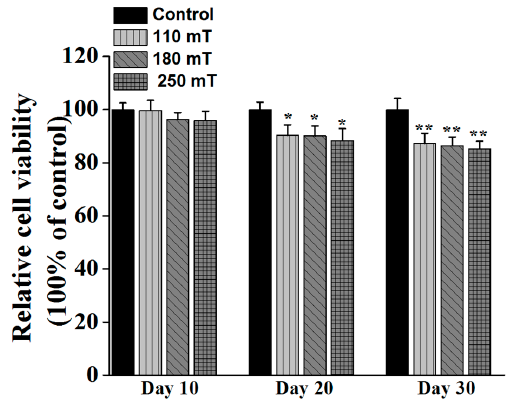
Figure 7. MTS viability of MG-63 osteoblast-like cells growing on ellipsoidal multilayered 3D structures having the layers spatially separated by cylindrical pillars, as a function of the applied static magnetic fields. Results for unstimulated samples (controls) are shown for comparison. Each bar represents the mean ± STD. Statistical significance was determined by Student’s t -test (* p ≤ 0.05, ** p ≤ 0.001). ALP (Alkaline Phosphatase) is one of the substances in the ECM (extracellular matrix) that indicates if the osteoblast cells have entered the period of ECM development and